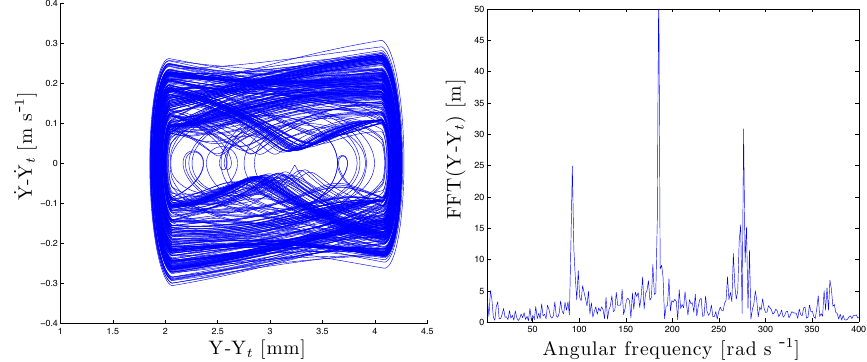
Fig. 18 Phase portrait (left), Y − Y t versus ˙Y − ˙Y t and Fourier spectra (right) for the angular frequency ω = 185 rad s − 1 and the gaps between the rotor frame and the impact element c 1 = c 2 = 1